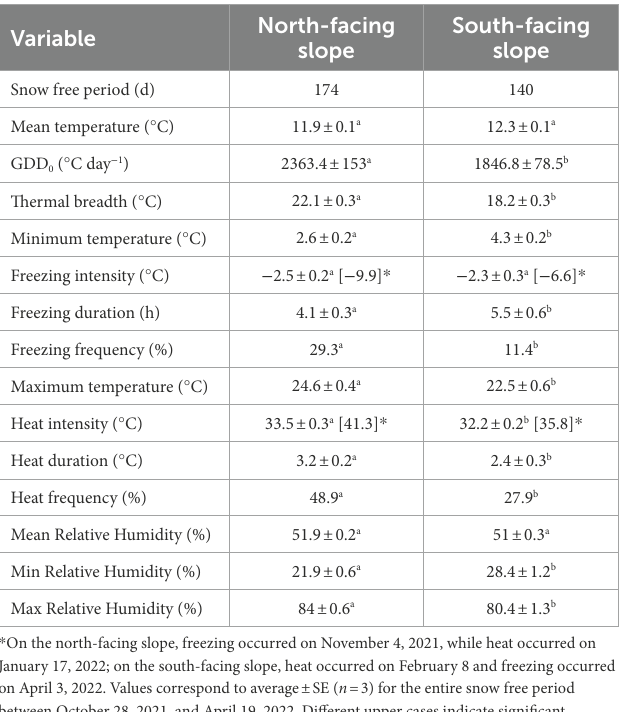
TABLE 1 Air temperature and moisture conditions measured on two contrasting slopes in the alpine zone of the Nevados de Chillán volcano complex.